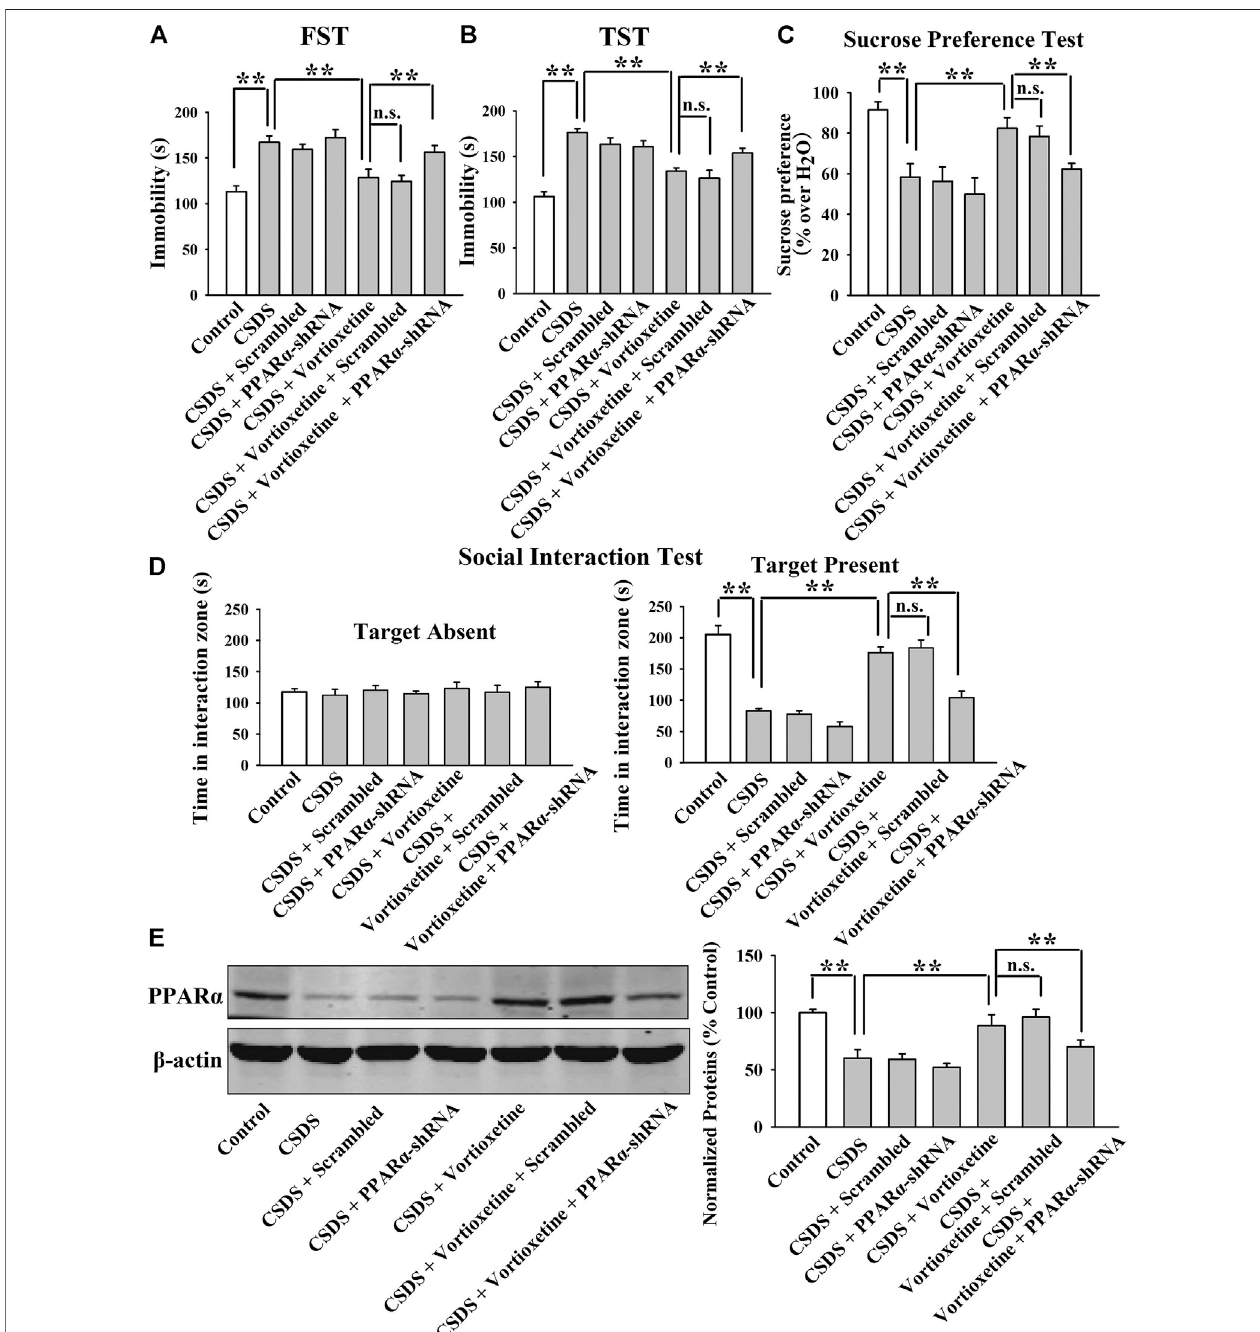
FIGURE 8 | AAV-PPAR α -shRNA completely abolished the antidepressant-like actions of vortioxetine in the CSDS model. (A – D) The (CSDS + vortioxetine + PPAR α -shRNA)-treated mice showed signi fi cantly longer immobility in the FST and TST as well as lower sucrose preference and social interaction than the (CSDS + vortioxetine)-treated and (CSDS + vortioxetine + Scrambled)-treated mice. (D) The (CSDS + vortioxetine + PPAR α -shRNA)-treated mice had notably less expression of hippocampal PPAR α than the (CSDS + vortioxetine)-treated and (CSDS + vortioxetine + Scrambled)-treated mice. For (A – D) , n (cid:2) 10 per group; For (E) , n (cid:2) 5 per group. Thedataareexpressed asthemeans ± S.E.M.;** p < 0.01;n.s.,nosigni fi cance.Thecomparisons weremadebytwo-wayANOVAfollowedbyBonferroni ’ stest.